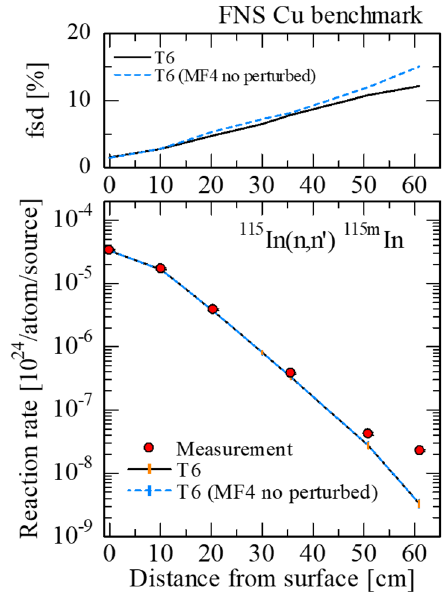
Fig. 8. Comparison of 115 In(n,n’) 115m In reaction rate distribution and the standard deviation between T6 and the result ignoring perturbation of angular distribution.